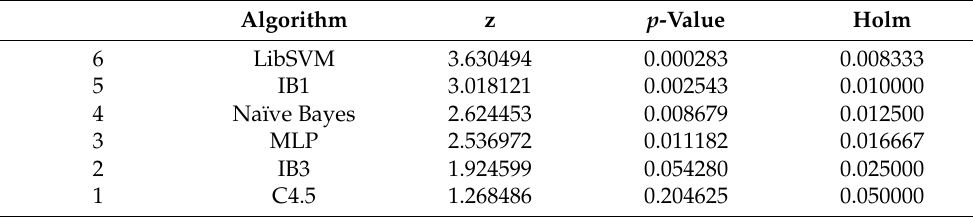
Table 8. Results obtained by the Holm’s test.